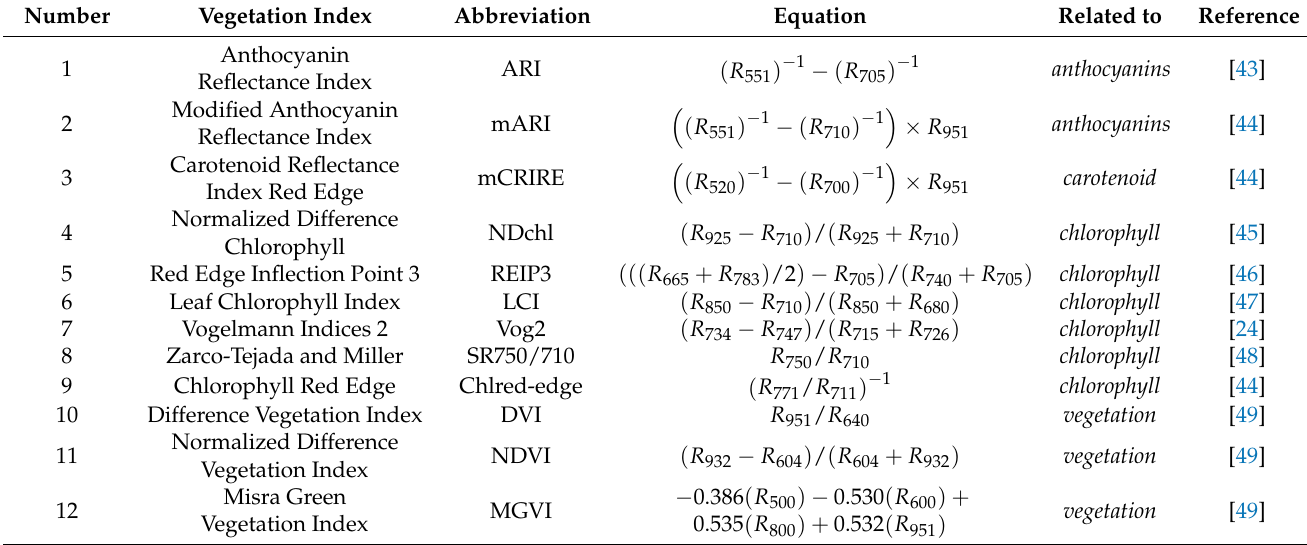
Table 1. Vegetation indices used for measuring reflectance changes between leaves from asymptomatic, diseased, and healthy plants of armillaria -diseased